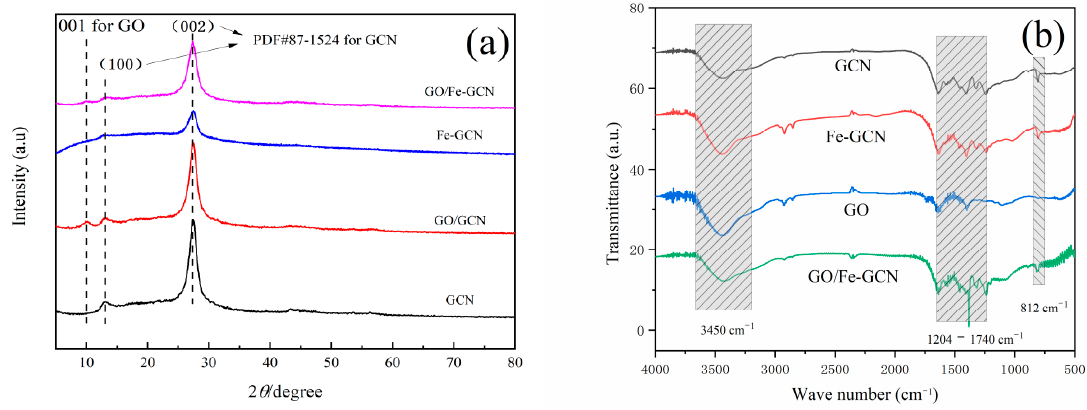
Figure 2. XRD spectrum of the samples ( a ), and FT-IR patterns for samples ( b ).